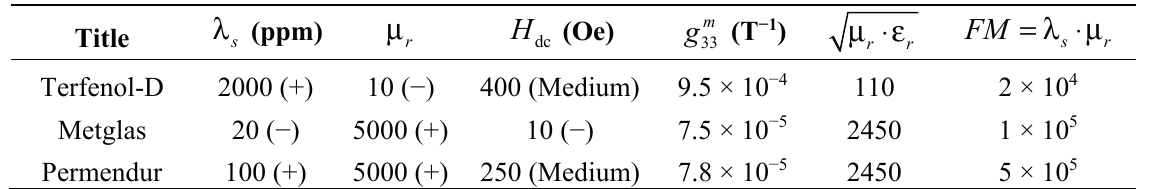
Table 1. Magnetic and magnetostrictive parameters of Terfenol-D, Metglas, and Permendur alloy *.